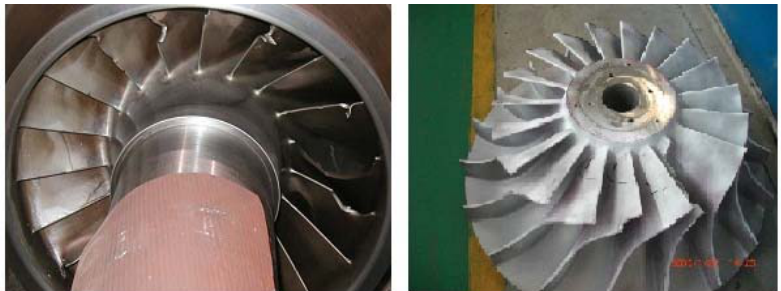
Figure 1. Pictures of centrifugal compressor blade